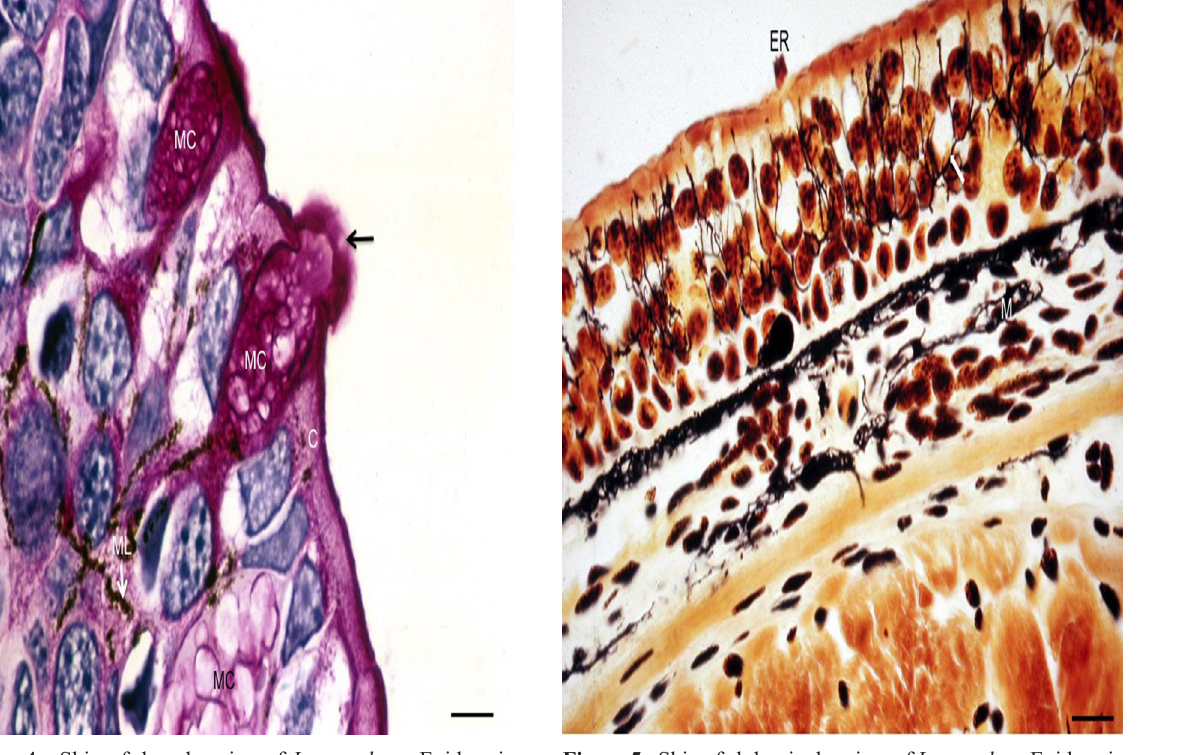
Figure 4 - Skin of dorsal region of L. paradoxa . epidermis with PAS-positive mucus-secreting (MC) cells. One of these cells is releasing the mucus at the surface (arrow), contributing to the formation of the cuticle (C). Melanina (ML). PAS. Bar: 20 μm.